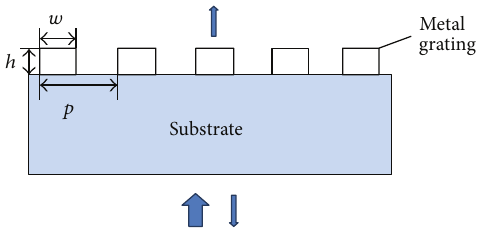
Figure 1: Schematic of traditional subwavelength metal grating.